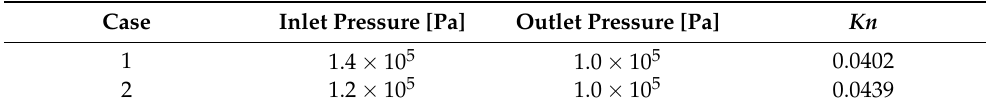
Table 1. Simulation cases for the channel fl ow.